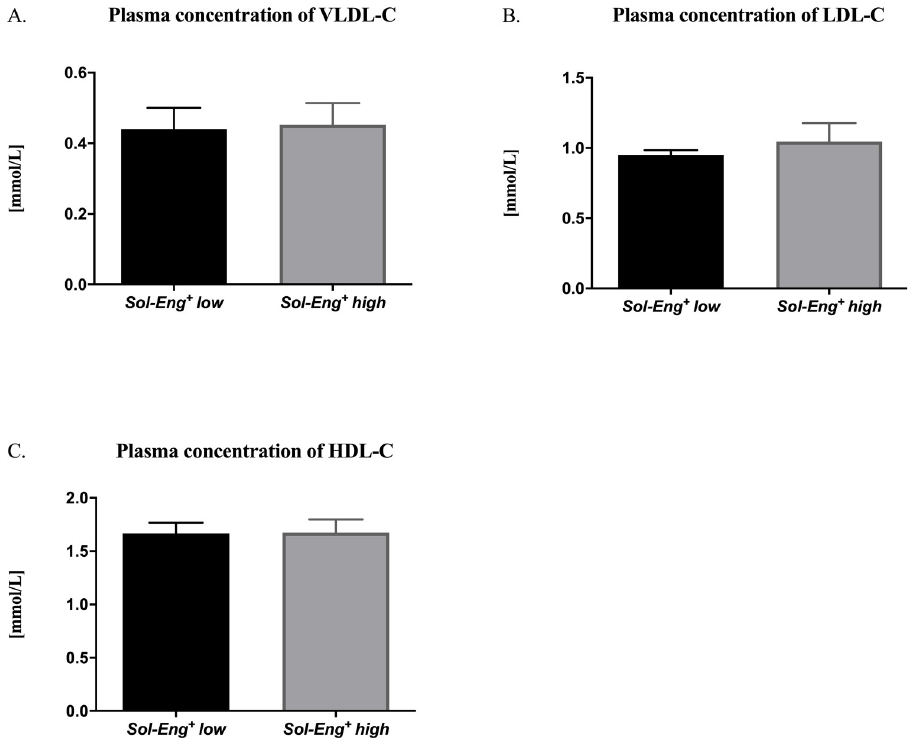
Fig 1. Lipid profile of Sol-Eng + mice . Plasma concentration of VLDL-C (A), LDL-C (B), HDL-C (C) in Sol-Eng + high mice and Sol-Eng + low mice fed high fat diet for six months. Data are shown as mean ± S.E.M., Mann-Whitney test. n = 8 mice per